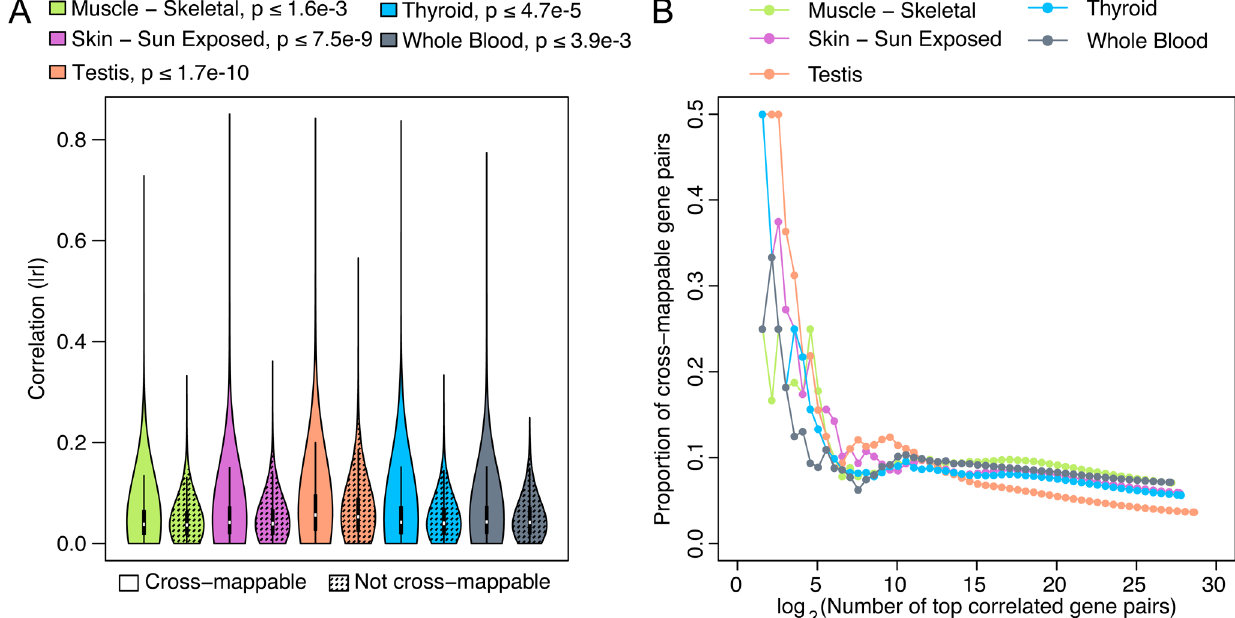
Figure 4. Effect of cross-mappability on co-expression. ( A ) Comparison of co-expression between randomly drawn pairs of cross- mappable genes and not cross-mappable genes. Each violin plot shows the distribution of the absolute Pearson correlation (y-axis) between corrected gene expression levels of randomly drawn 10,000 gene pairs in a tissue (color). P-value of the Wilcoxon test to determine whether cross-mappable genes are more correlated than not cross-mappable genes in each tissue is shown in the legend. ( B ) Fraction of top co-expressed genes that are cross-mappable and thus potential false